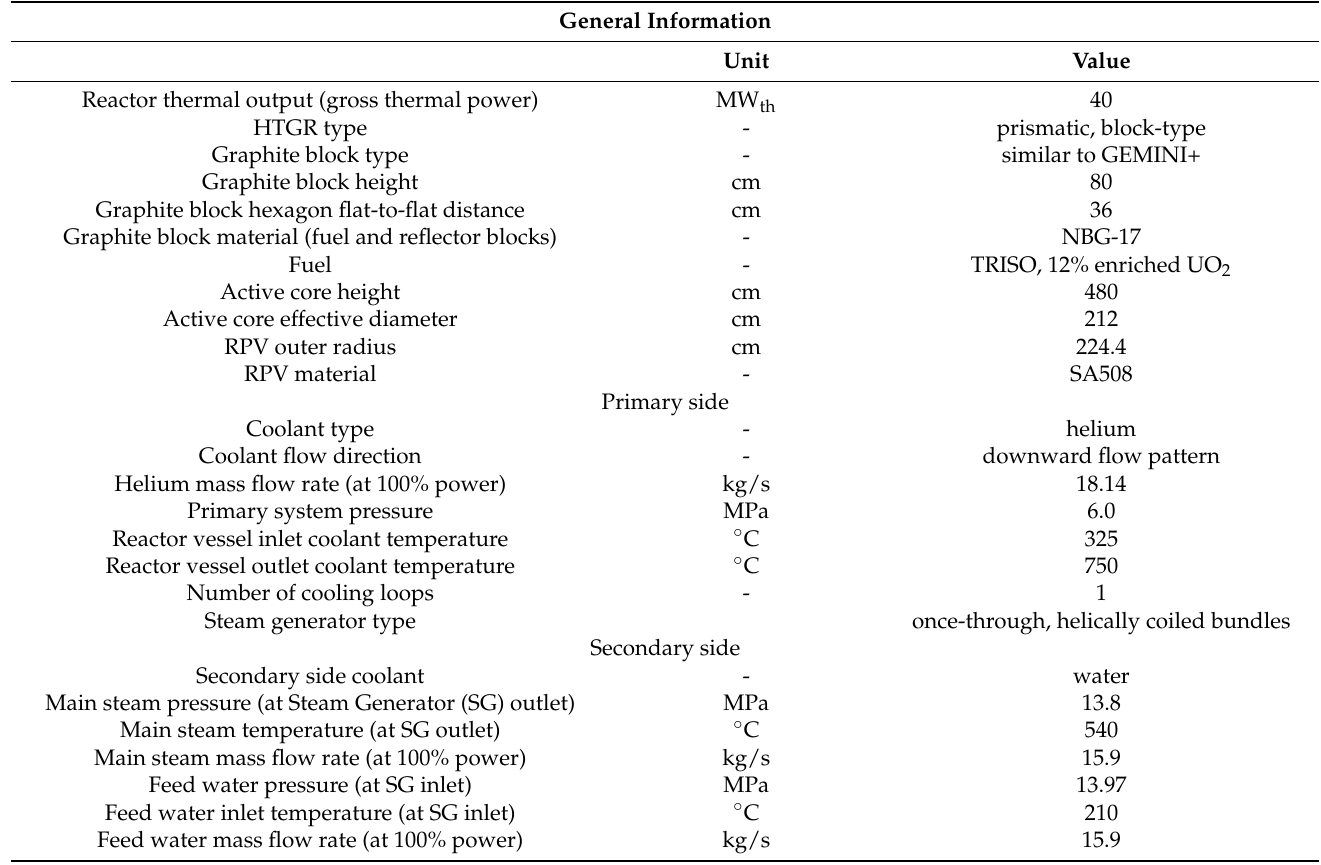
Table 3. General TeResa plant data—reference configuration, design values.